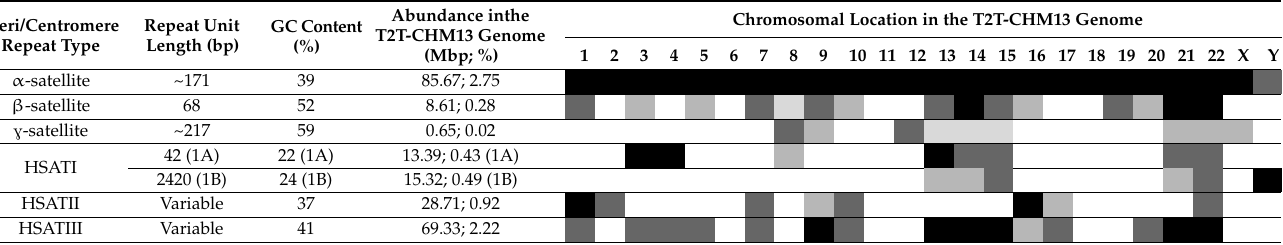
Black square: >1 Mbp of sequence is present on the indicated chromosome; dark gray square: 100 kbp–1Mbp is present; light gray square: 10–100 kbp is present; white square: <10 kbp is present. Calculations include